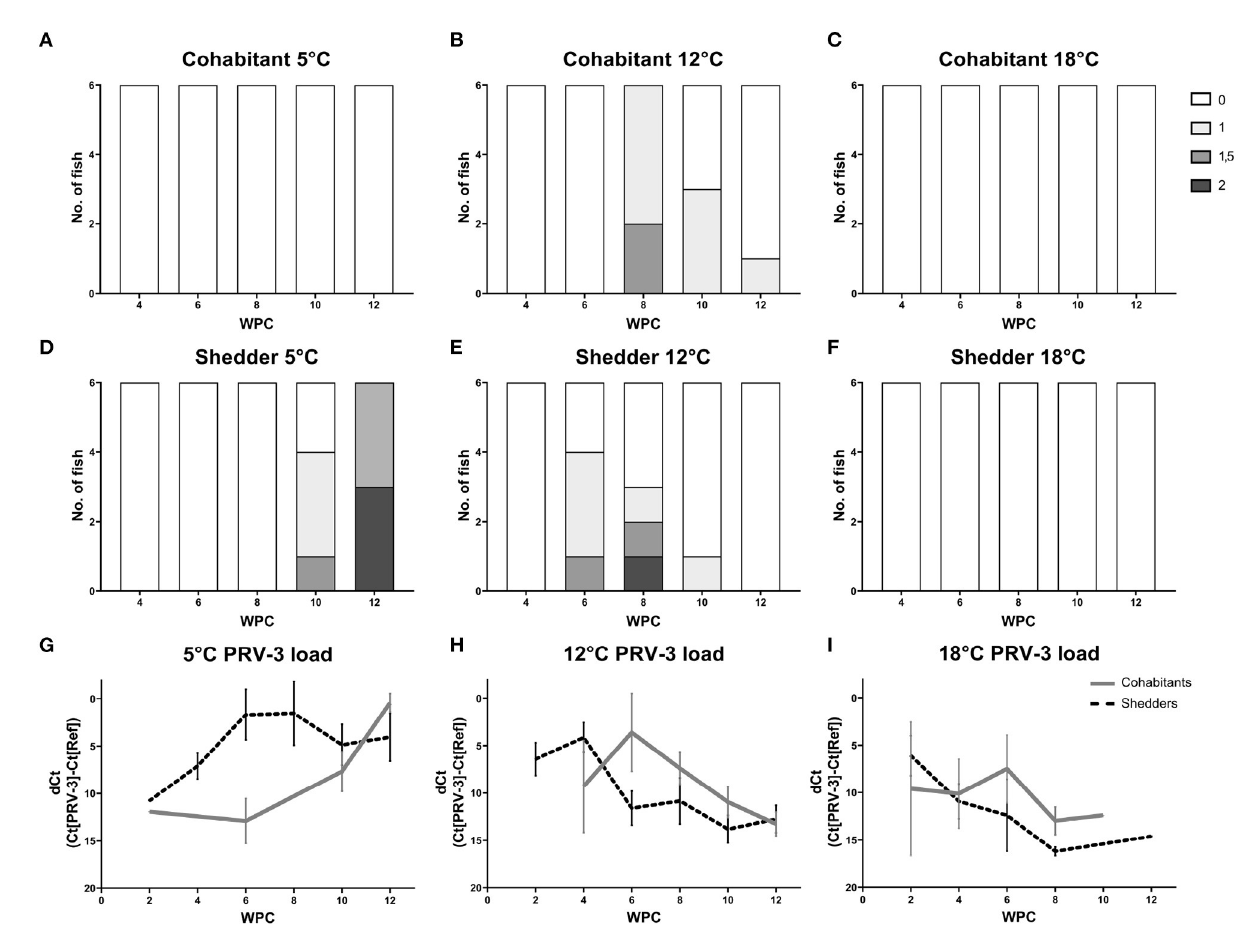
FIGURE4 Heart histopathology of shedders (A–C) and cohabitants (D–F) of PRV-3 exposed fish in comparison to dCt values (G–I) . Histoscore 0 = no lesions, 1 = mild, 1.5 = moderate, 2 = severe. Error bars show SD.